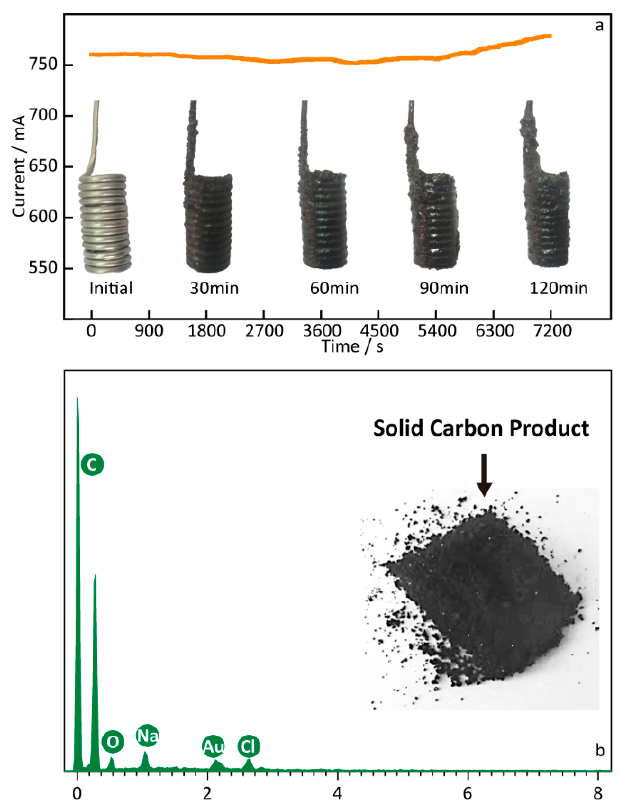
Figure 2. ( a ) Cell–current curve and digital photos of the Fe cathode after different electrolysis times at 550 °C. ( b ) EDS analysis of the solid carbon obtained from the Li 1.43 Na 0.26 K 0.21 CO 3 electrolysis at 2.5V.